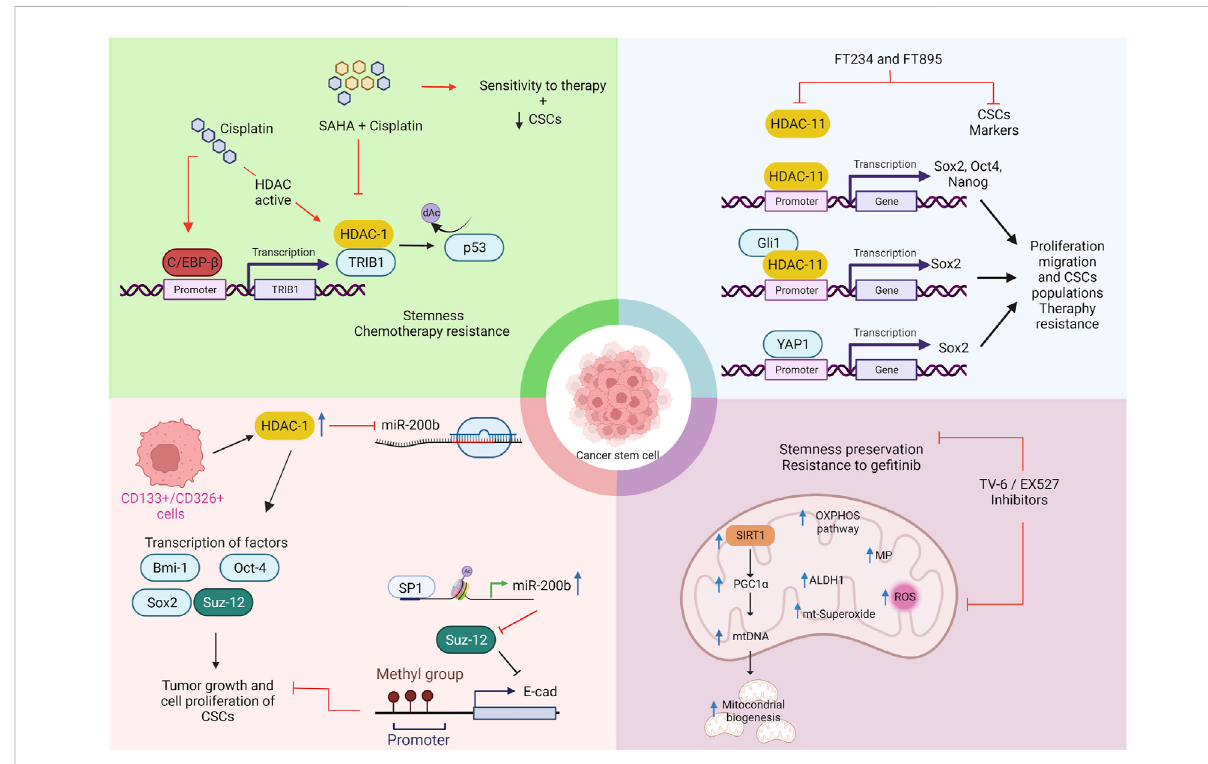
FIGURE 3 Strategies of CSCs subpopulations that promote the phenotype resistant tumor cells to therapies mediated by HDACs in lung cancer. Created withbiorender.comHDACinhibitors(SAHA=Vorinostat,FT234,FT895);Ac,acetylation;TRIB1=tribblespseudokinase1;C/EBP- β ,CCAATenhancer binding protein beta; YAP1, yes associated protein 1; SOX2, SRY-Box Transcription Factor 2; OCT4, Octamer-binding transcription factor 4; Bim-1, BMI1 Proto-Oncogene, Polycomb Ring Finger; PRC2, polycomb repressive complex 2; Suz-12 = SUZ12 Polycomb Repressive Complex 2 Subunit; EED, embryonic ectoderm development; RbAP 46/48, retinoblastomabinding protein p48; EZH2, Enhancer Of Zeste 2 Polycomb Repressive Complex 2 Subunit; OXPHOS, oxidative phosphorylation; ROS, reactive oxygen species. Phosphorylation Acetylation Up-regulation Methylation Inhibition Mechanism promoted by treatments